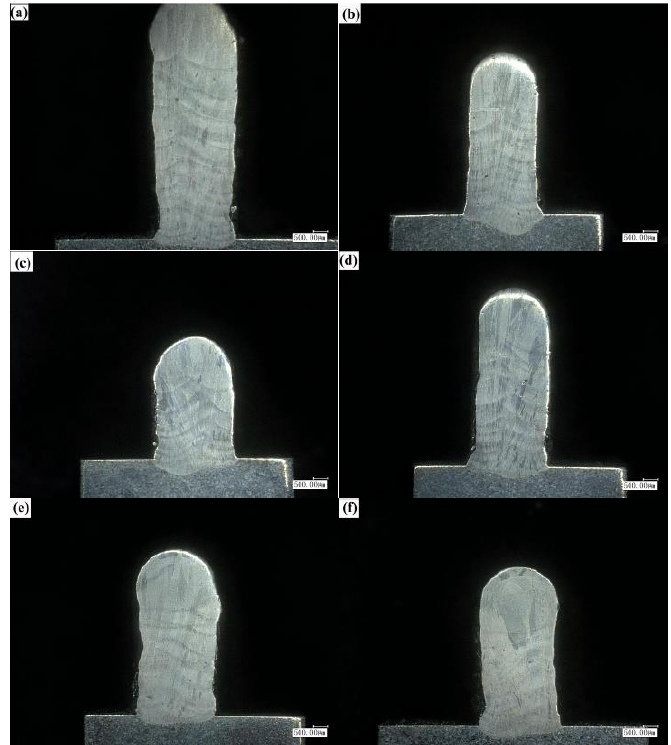
Figure 12. Cross section of cladding layer: ( a ) Constant laser power, air cooling, Z-axis lift 0.7 mm processing conditions, ( b ) decreasing laser power step-by-step, water cooling 7.5 L/min, Z-axis lift 0.7 mm processing conditions, ( c ) decreasing laser power layer-by-layer, water cooling 7.5 L/min, Z-axis lift 0.2 mm processing conditions, ( d ) decreasing laser power layer-by-layer, water cooling 7.5 L/min, Z-axis lift 0.5 mm processing conditions, ( e ) decreasing laser power layer-by-layer, water cooling 4 L/min, Z-axis lift 0.7 mm processing conditions, ( f ) decreasing laser power layer-by-layer, air cooling, Z-axis lift 0.7 mm processing conditions.